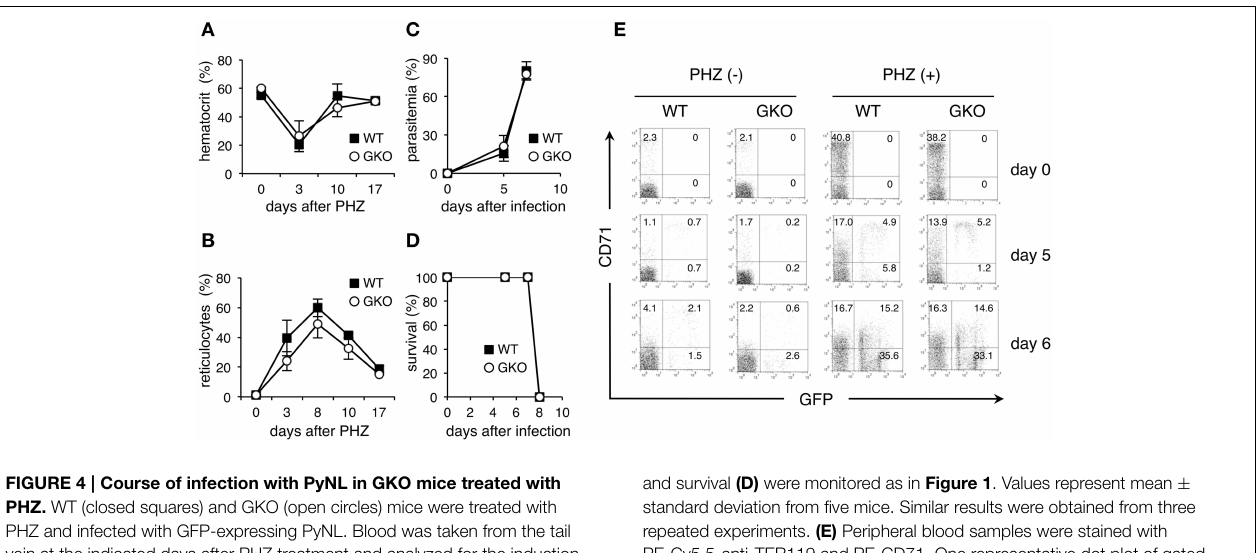
and survival (D) were monitored as in Figure 1 . Values represent mean ± standard deviation from five mice. Similar results were obtained from three repeated experiments. (E) Peripheral blood samples were stained with PE-Cy5.5-anti-TER119 and PE-CD71. One representative dot plot of gated TER119 + cells separated based on their expression of CD71 and GFP is shown for each condition. The numbers indicate percentages within each